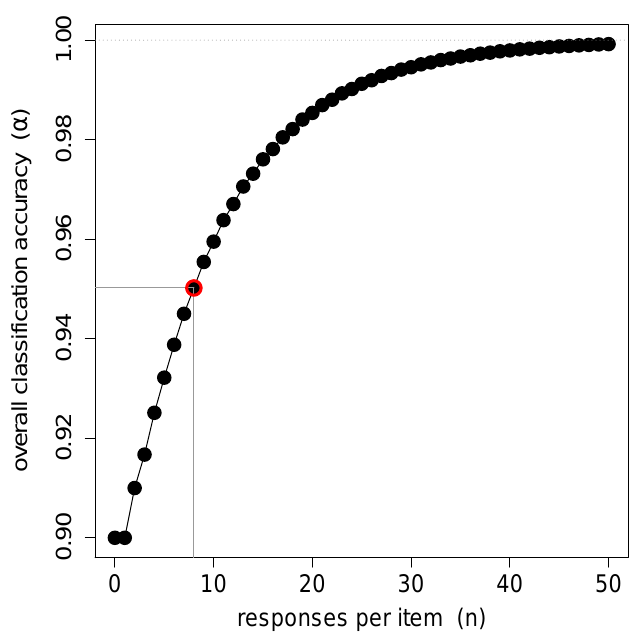
Figure 2. The overall classification accuracy α as a function of the number of responses per item n estimated for BF with p 1 = 0.9 and θ = 0.7 and fully known. Based on these calculations, one needs at least 8 responses per item to achieve an accuracy of 0.95.